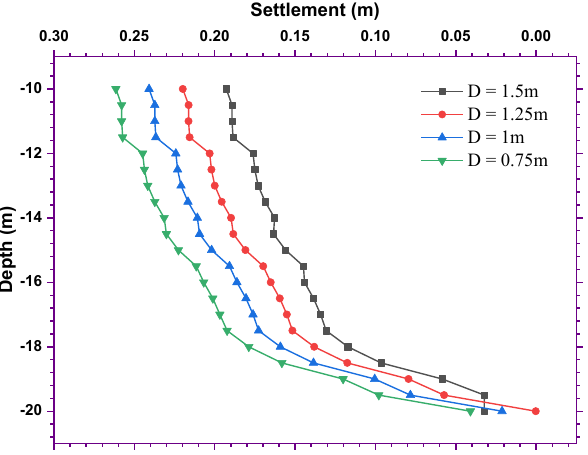
Figure 5: Effect of stone column diameter (D) on vertical settlements as a function of